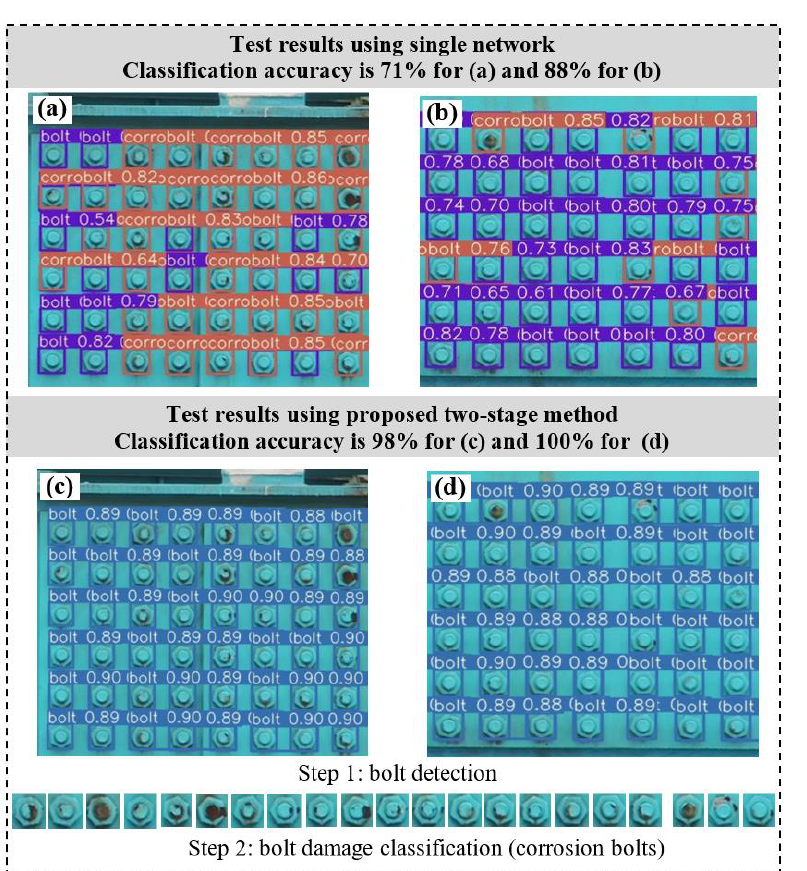
Figure 11. Example of test results using two methods: ( a ) and ( b ) are the results of directly identifying the bolts and classifying the type of bolts using a single network, and ( c ) and ( d ) are the results of the same two images using an object detection network to first segment the bolts and then classify them with the classification network.